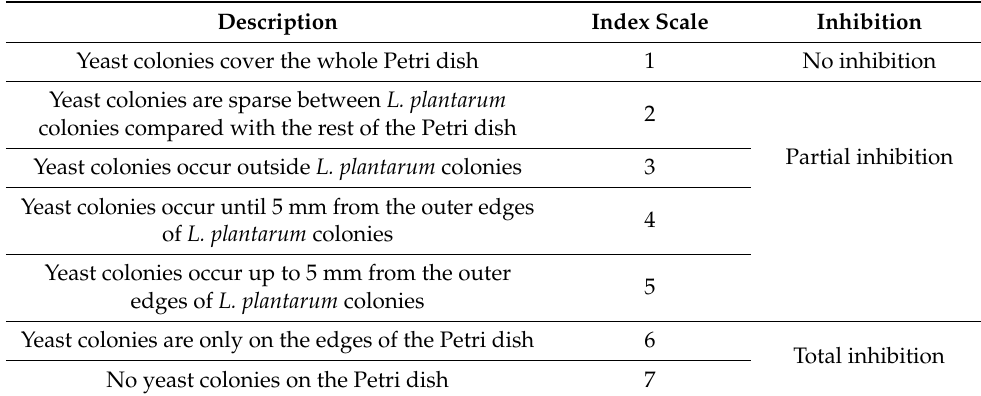
Table 3. The index scale with a description of scale values from the overlay method on artificial media. Three levels of inhibition represent the level of inhibition for PCA